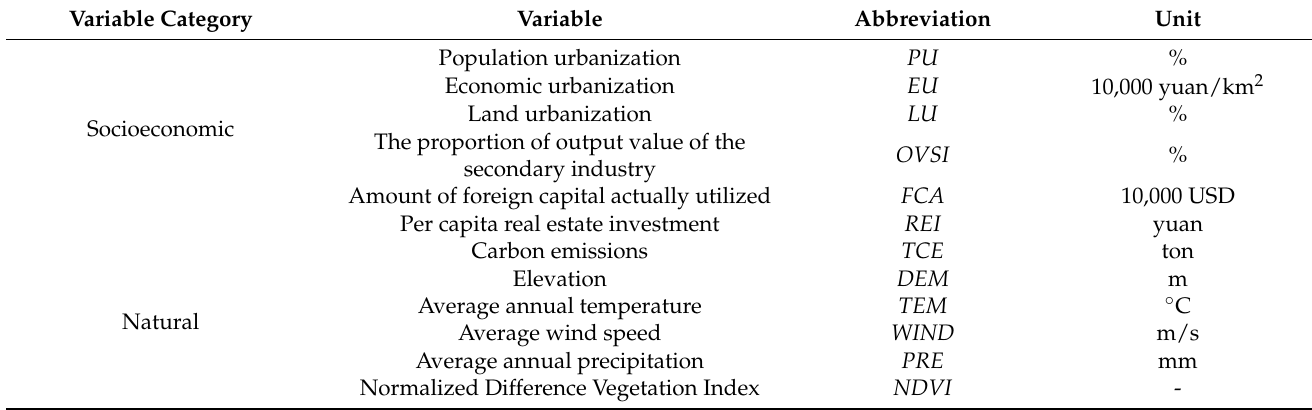
Table 1. Variable